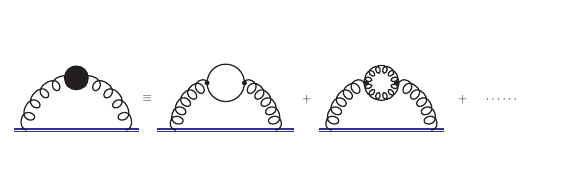
Figure 2. Heavy quark self-energy with e ff ective gluon propagator. Resummation takes into account the diagrams for the hard process (Fig.1) among